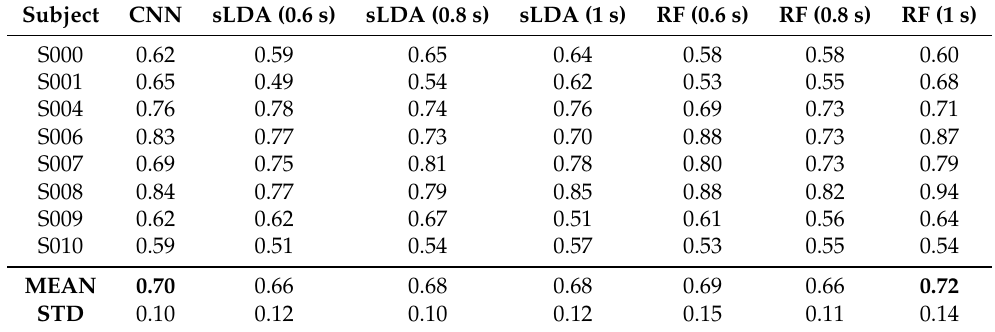
Table A2. Comparison of classification performance (in terms of recall) in validation from Dataset 1 .